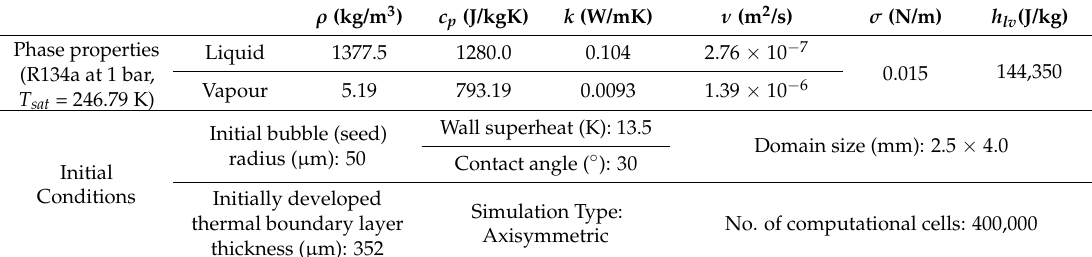
Table A3. Fluid properties and initial conditions (base case for R134a, Series B–D).